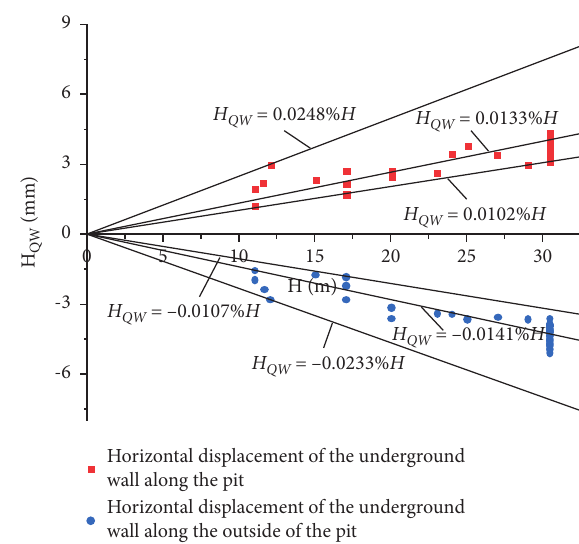
Figure 17: The relationship between the horizontal displacement of the underground wall and the excavation depth.